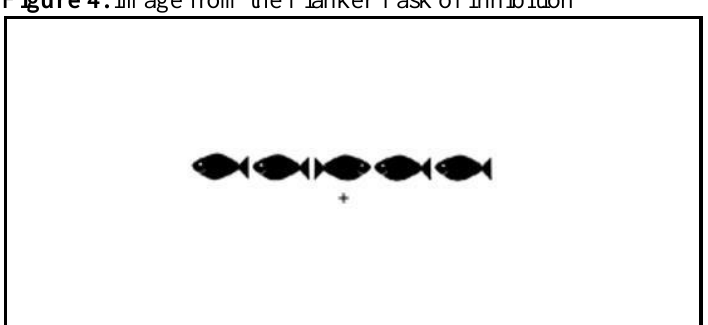
Figure 4. Image from the Flanker Task of Inhibition